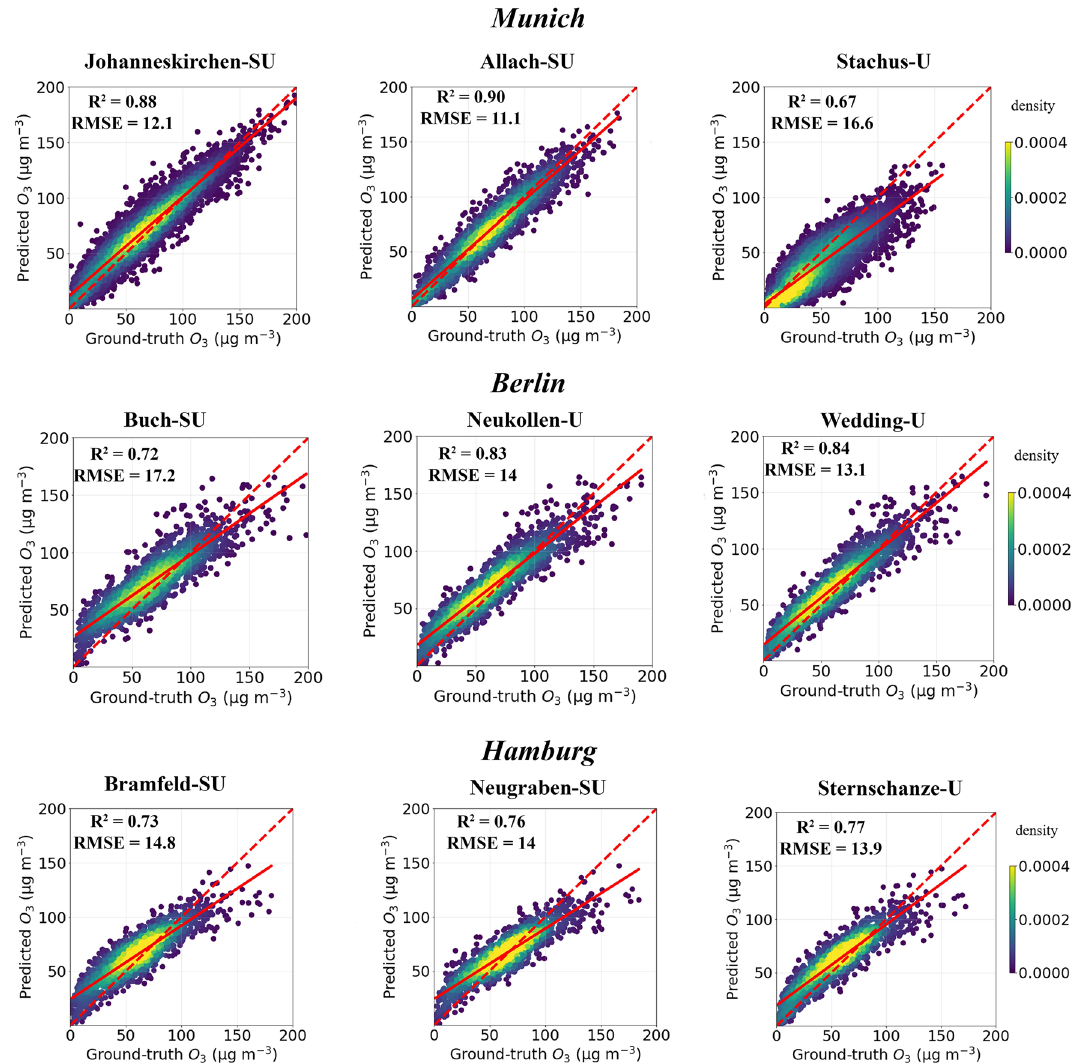
Figure 3. Density scatter plots of predicted ozone by “ML_s_rh_t_wd_blh_no” trained for Lothstrasse station at Munich vs ground-truth ozone measurements for different locations. First row shows the stations for Munich, second row for Berlin and third row for Hamburg stations. U represents urban station and SU represents suburban station. Red solid line represents the linear fit and red dotted line represents 1:1